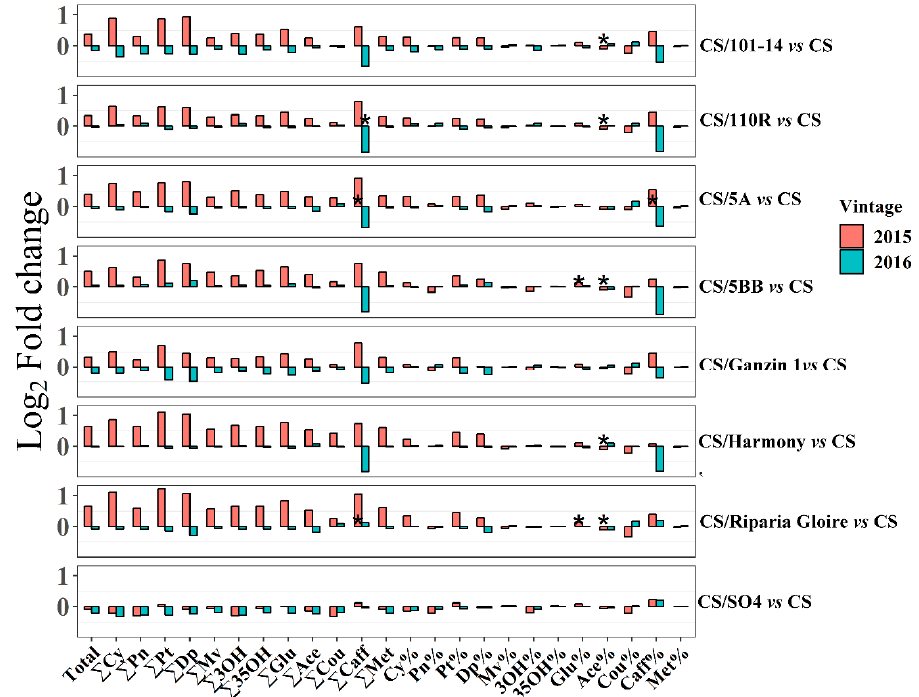
Figure 3. Effects of each rootstock on anthocyanins in two seasons (2015–2016). Each data represent the log2 fold change of anthocyanin content/proportion in berries on each grafted vine relative to those on own-rooted vines. ‘Total’, the concentration of total anthocyanins; ‘ ∑ ’, the total concentration of different fractions of anthocyanins; ‘%’, the proportions of different fractions of anthocyanins; ‘Cy’, cyanidin; ‘Pn’, peonidin; ‘Pt’, petunidin; ‘Dp’, delphinidin; ‘Mv’, malvidin; ‘Glu’, anthocyanins in glucoside form; ‘Ace’, acetylated anthocyanins; ‘Cou’, coumarylated anthocyanins; ‘Caff’, caffeoylated anthocyanins; ‘Met’, methoxylated anthocyanins; ‘3OH’, 3 (cid:48) -hydroxylated anthocyanins; ‘35OH’, 3 (cid:48) 5 (cid:48) -hydroxylated anthocyanins. The asterisk * in each bar indicates significant differences between grafted and own-rooted vines in the same season at the basis of student’s t -test at p < 0.05.